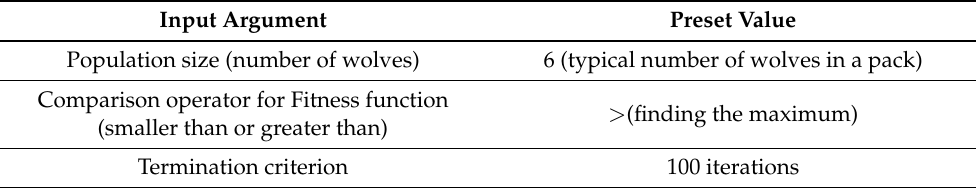
Table 4. GWO input